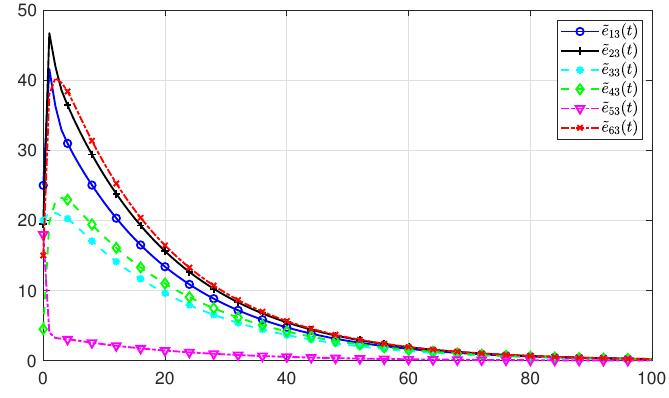
Figure 13. The simulations of ˜ e i 3 ( k ) of all the agents.